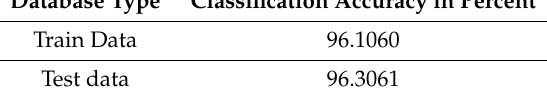
Table A3. The accuracies obtained for the train and test sets, by classifying the synthetic database with the expression obtained via GP, Equation